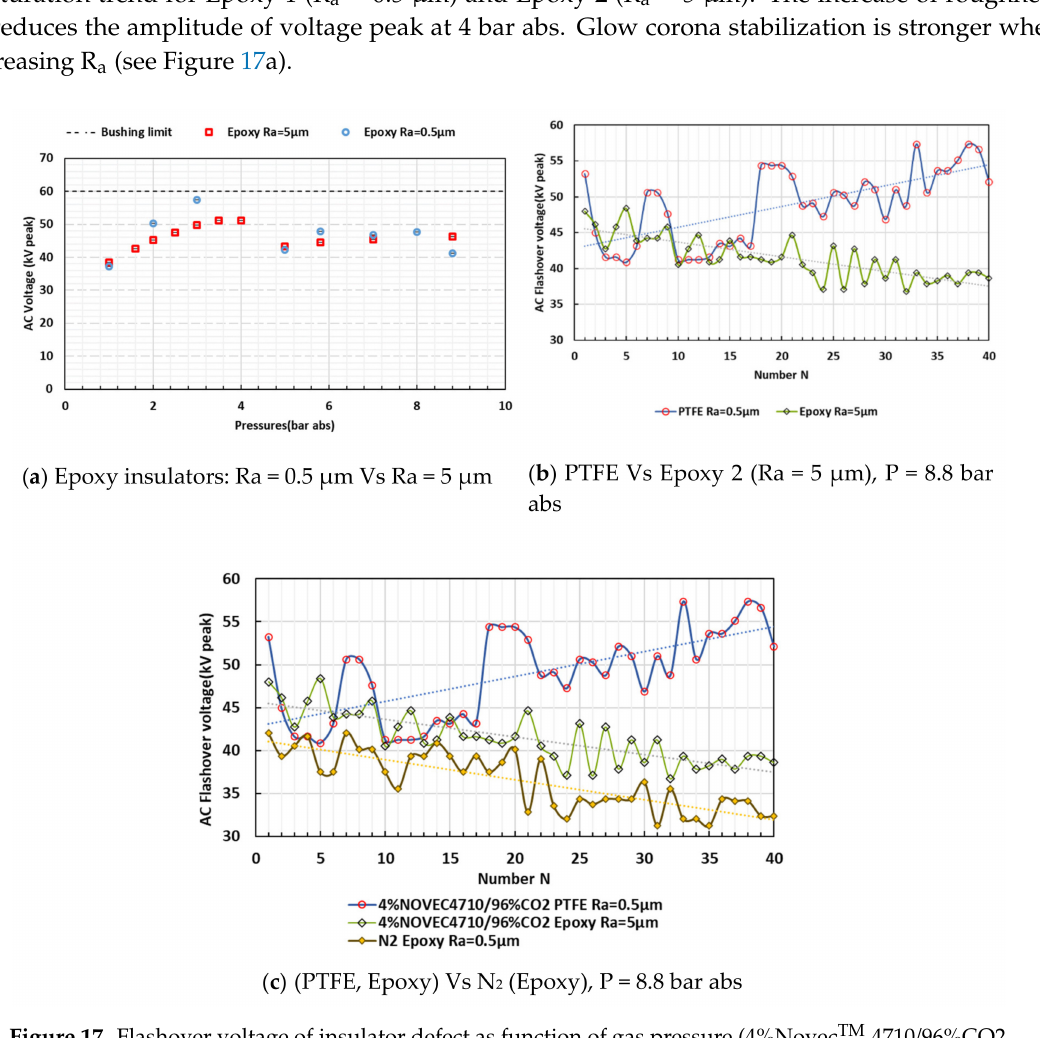
Figure 17. Flashover voltage of insulator defect as function of gas pressure (4%Novec TM 4710 / 96%CO2, Needle on HV